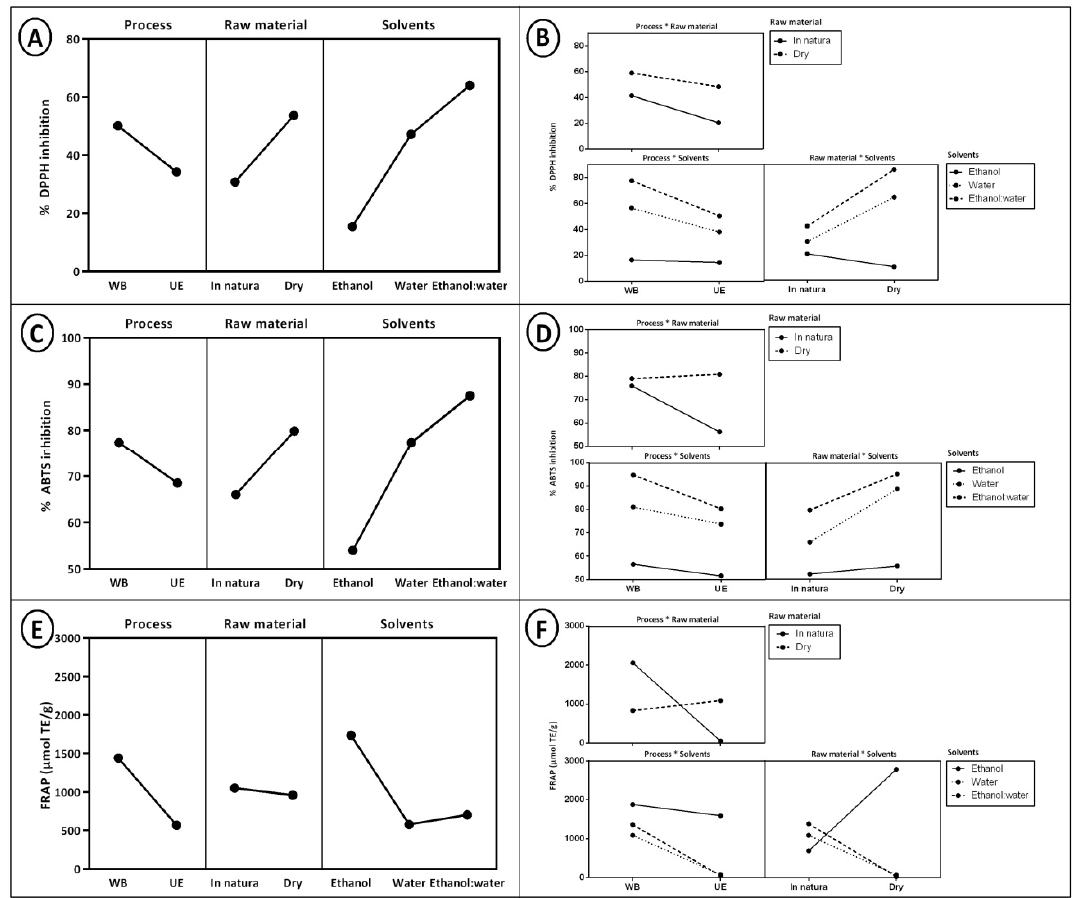
Figure 1. ( A ) Effects of extraction variables for DPPH; ( B ) Effects of interaction between extraction variables for DPPH; ( C ) Effects of extraction variables for ABTS; ( D ) Effects of interaction between extraction variables for ABTS; ( E ) Effects of extraction variables for ferric reducing antioxidant power (FRAP); ( F ) Effects of interaction between extraction variables for FRAP.